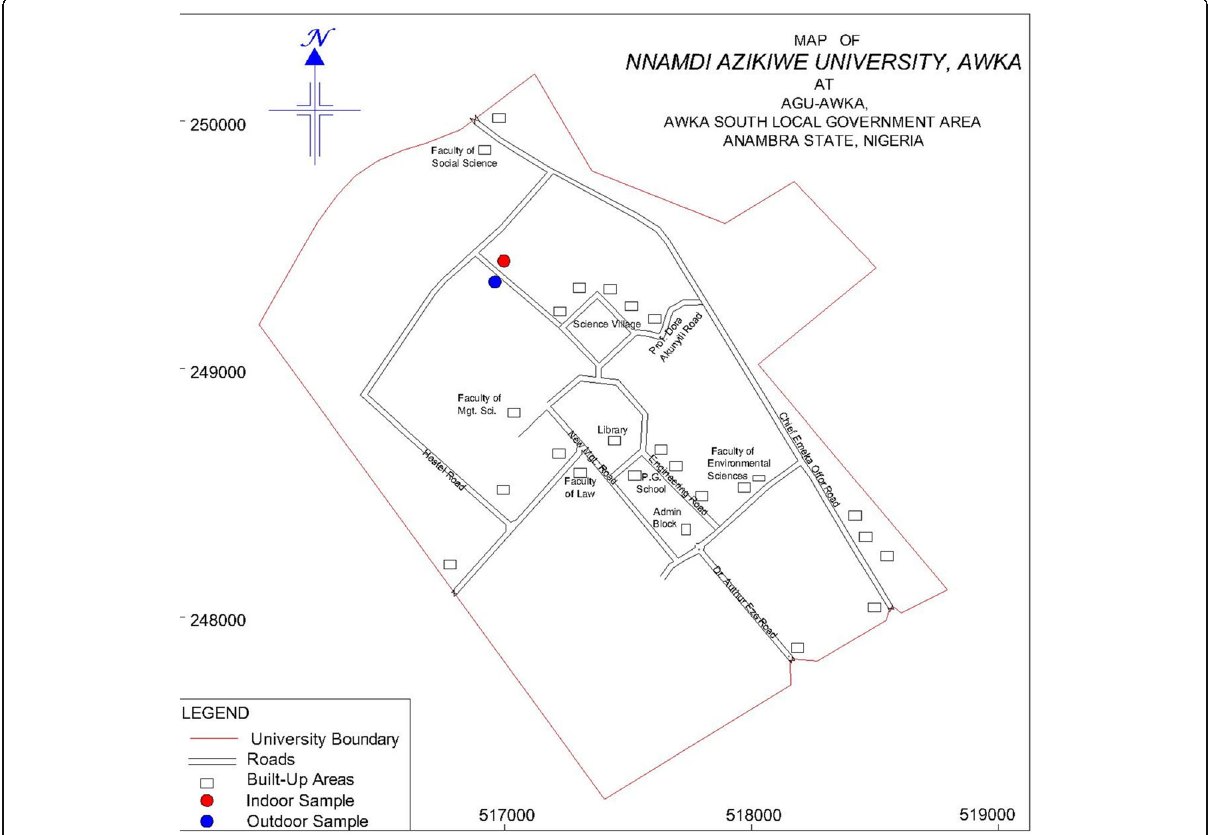
Fig. 1 Map of Nnamdi Azikiwe University Awka, Nigeria (red circular dot was the study